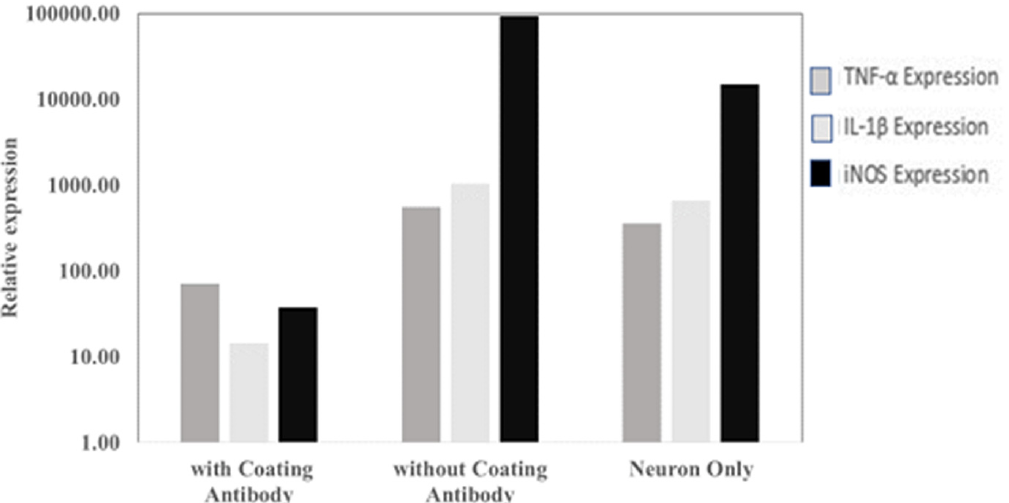
Figure 3. The level of TNF , IL1B and iNOS gene expression in the antibody-coated group, without antibody coating and neuron cells only.